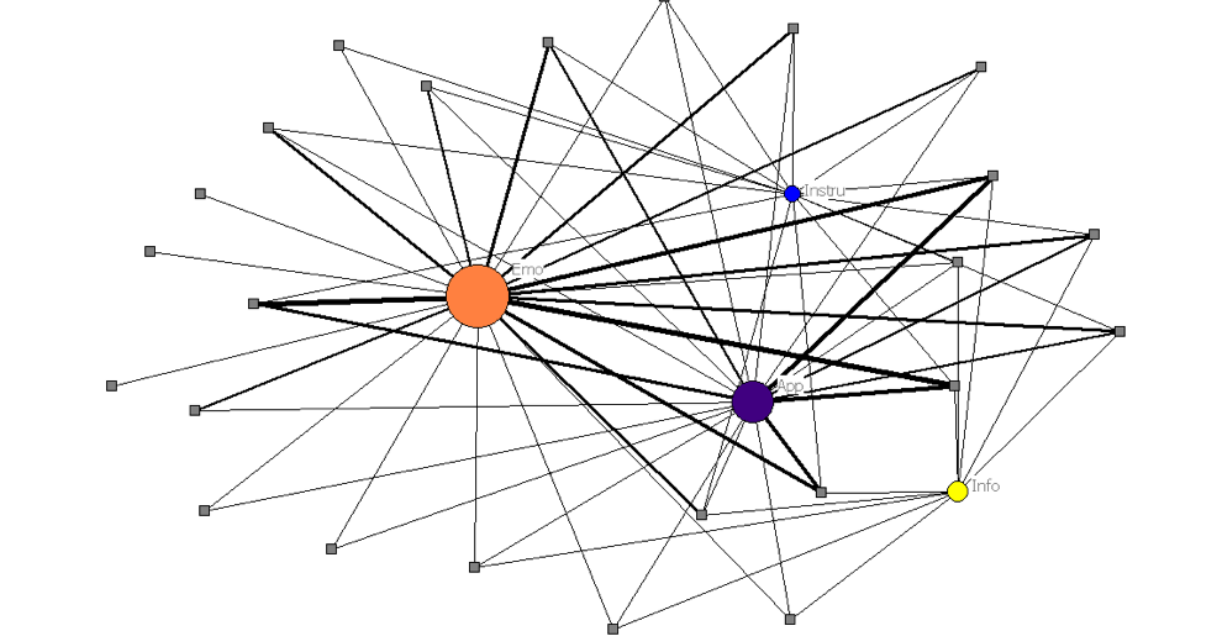
Figure 3. Two-mode network structure of social interactions for all types of support. The shape of the nodes distinguishes two sets of nodes as follows: squares represent participants and providers, and circles represent types of social support. In addition, the color of the circles represents each type of social support (orange, purple, yellow, and blue representing emotional, appraisal, informational, and instrumental support, respectively). Finally, the size of the circles indicates degree, and edge thickness represents the frequency of participants’interactions within each type of